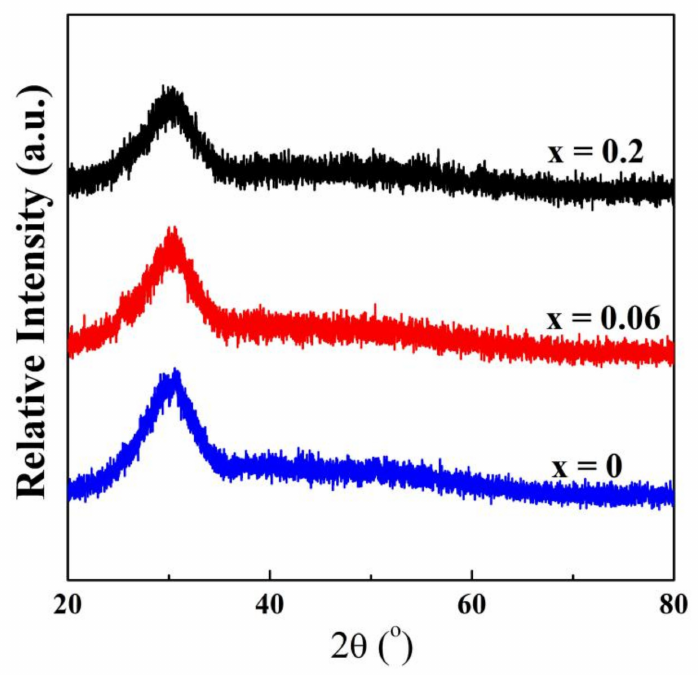
Figure 1. XRD patterns of Al 2 O 3 -(3-x)SrO: xSm 3+ (x = 0, 0.06, 0.2) glasses.